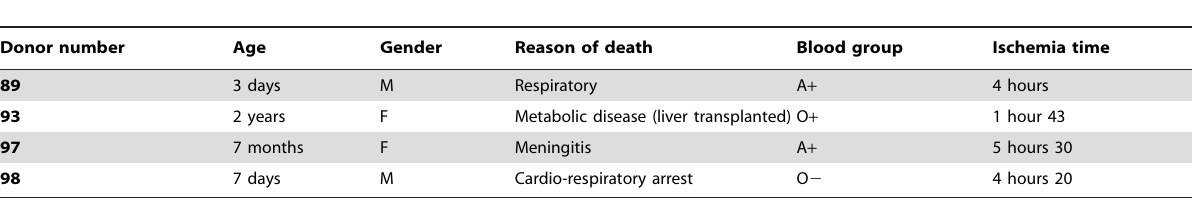
Table 1. Characteristics of the four liver donors from which HSC and ADHLSC were isolated.